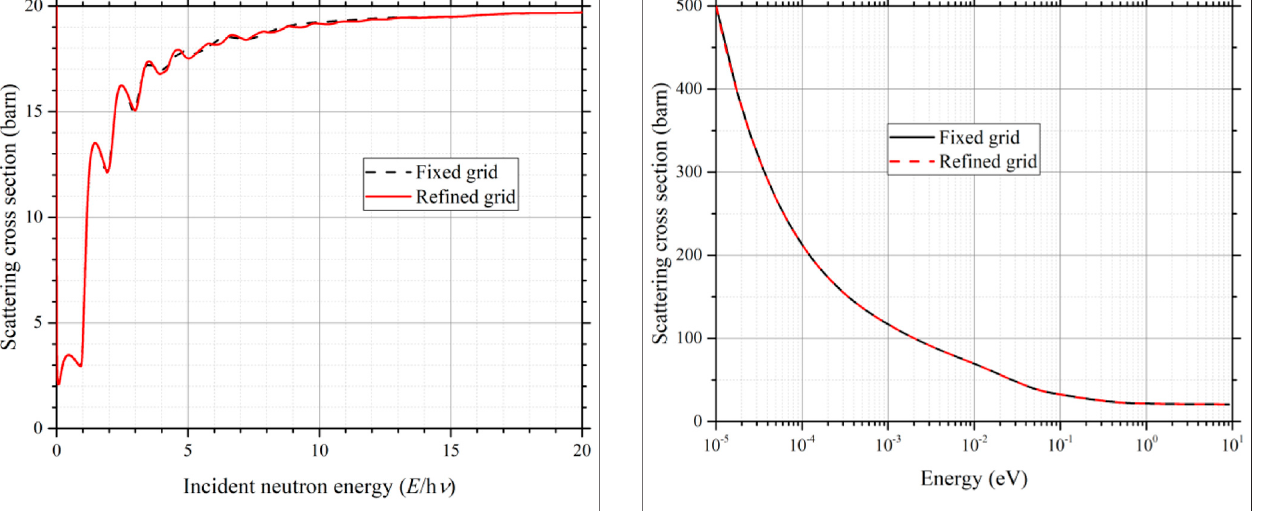
FIGURE 10 | Inelastic scattering cross sections of H 2